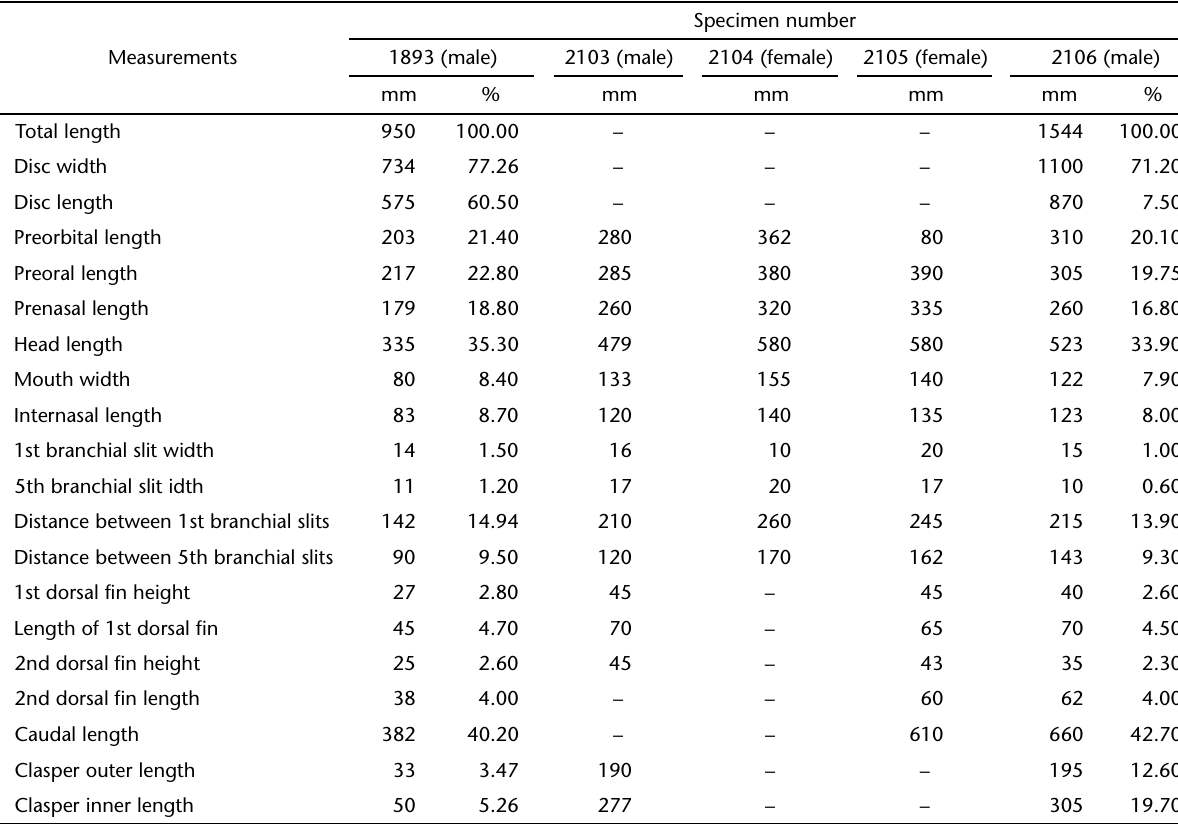
Table I. Measurements (in millimeters and percentages of total length, when available) taken from specimens of D. mennii ; all specimens are from the UERJ collection.